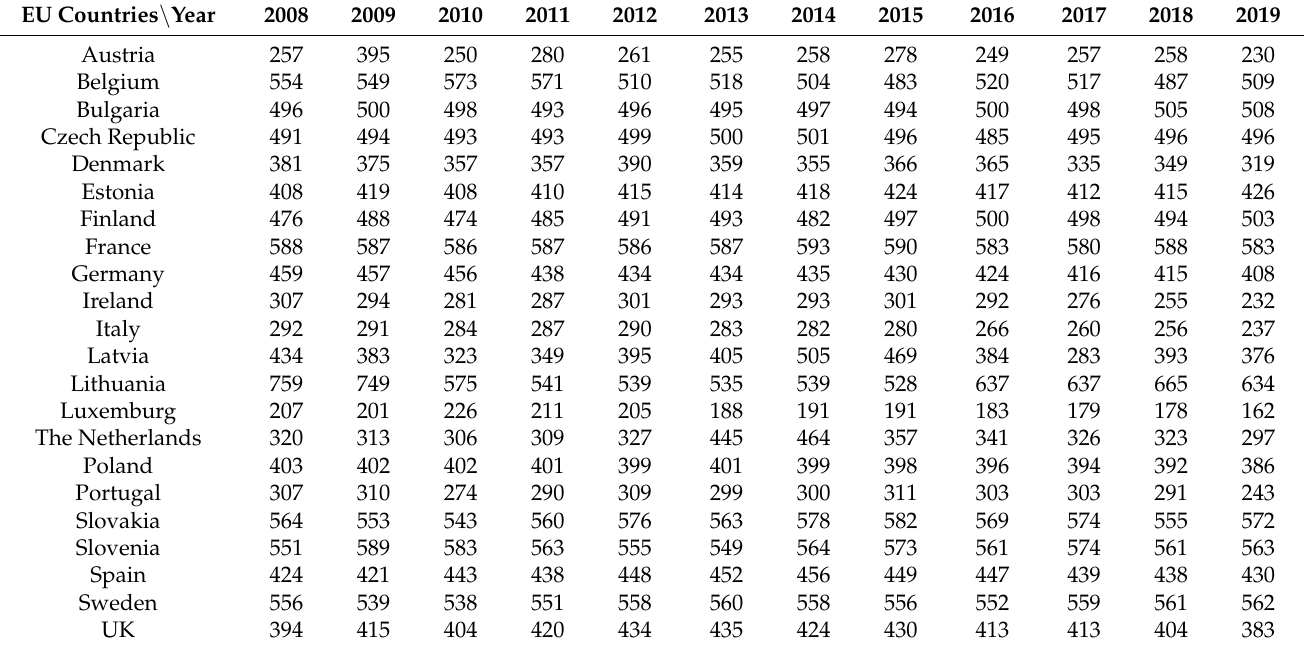
Table 4. Environmental footprint (m 2 /kWh) of electricity net mix in EU